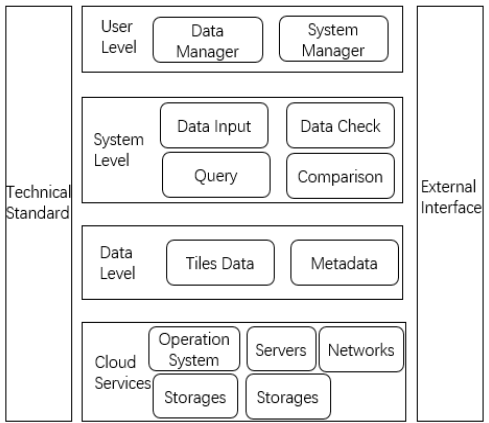
Figure 4. Multi-temporal image service system